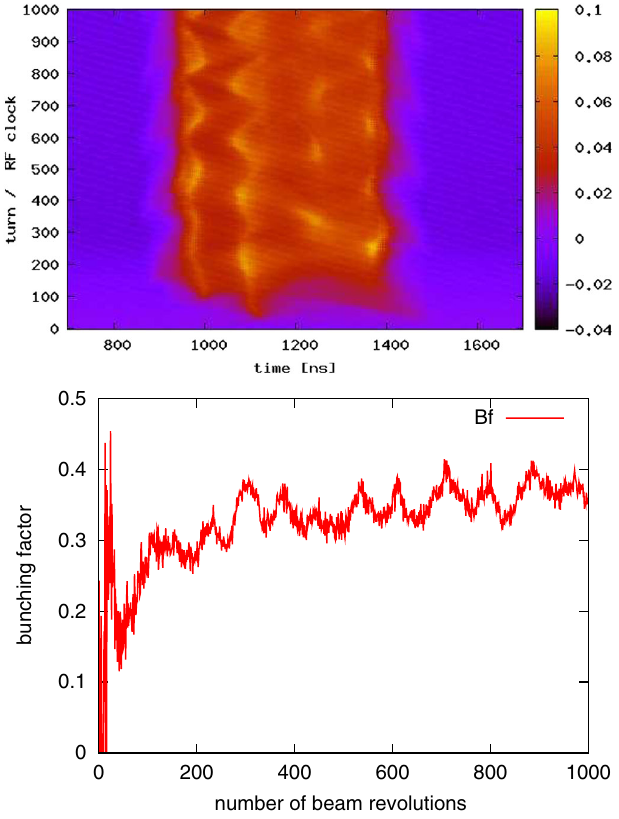
FIG. 6. (Color) (Upper) Mountain plot and (lower) bunching factor plot, with 80% second harmonic, momentum offset of (cid:1) 0 : 2% , and phase sweep of 60 degrees.